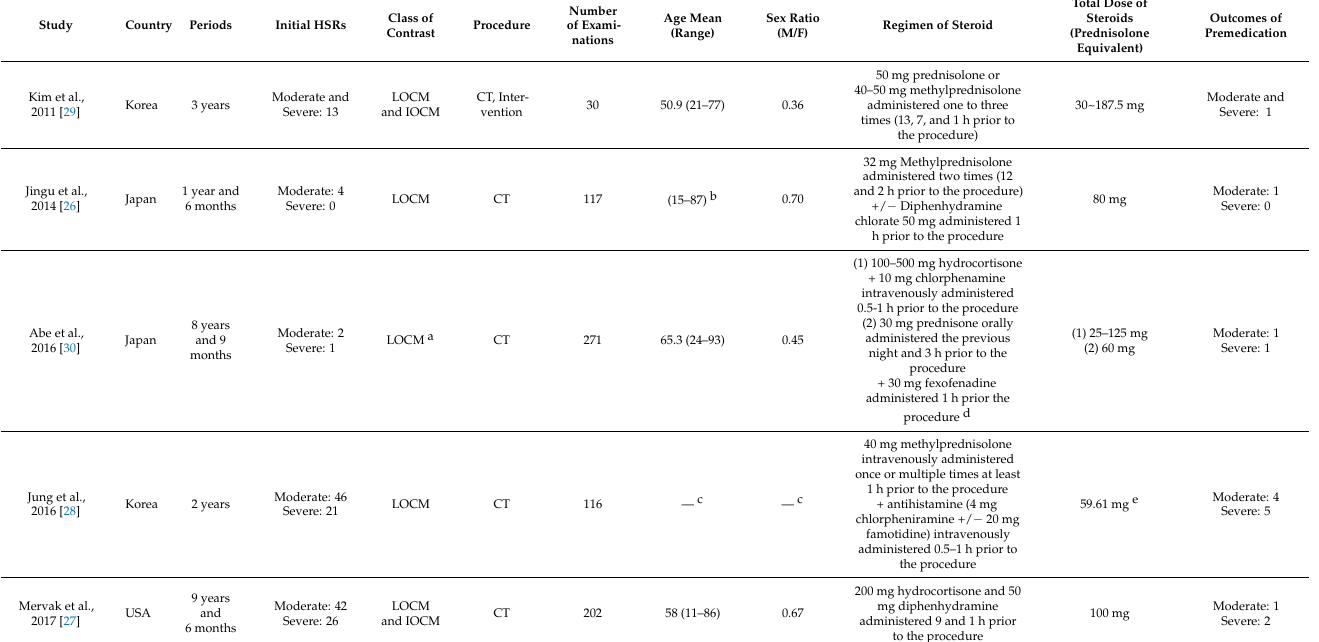
Table 1. Characteristics of the five included studies.